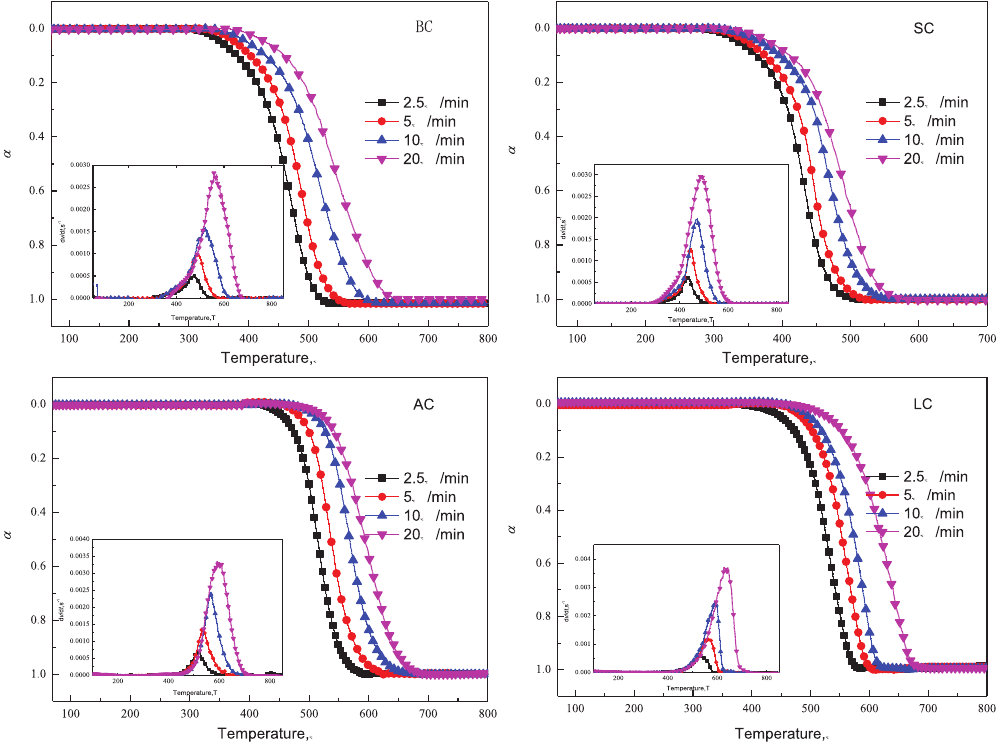
Figure 2: Conversion curves and conversion rate curves for different samples under different heating rates.